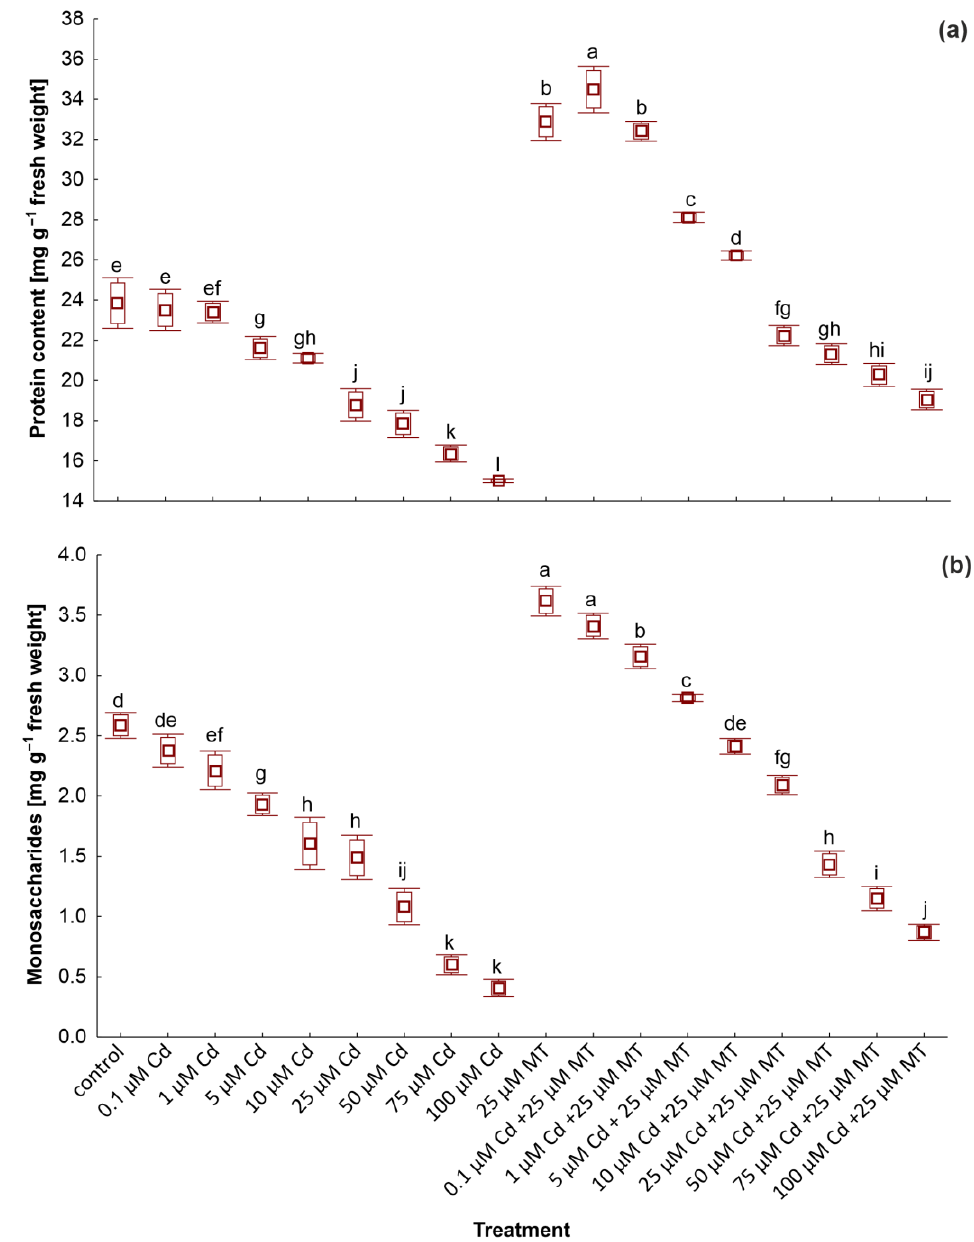
Figure 2. The content of soluble proteins ( a ) and monosaccharides ( b ) in W. arrhiza exposed to cadmium (Cd) or/with melatonin (MT) after 7 days of cultivation. The square represents the mean ( n = 5, biological replicate). The lower and upper hinges correspond to the lower and upper bounds of the 95% confidence interval of the means. The lower and upper whiskers extend from the hinge to the mean ± standard deviation. Means with the same letters are not significantly different ( p ≥ 0.05) according to Tukey’s post hoc test .